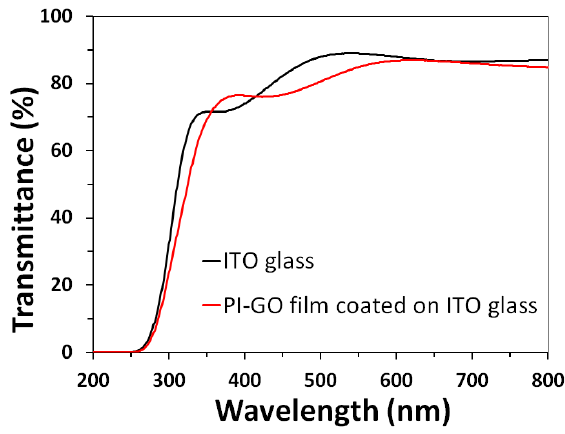
Figure 4. UV-vis spectra of a ITO glass and a PI-GO film coated on ITO glass.